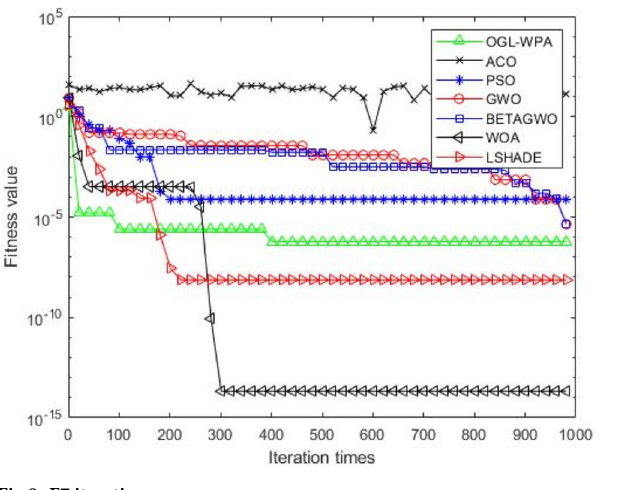
Fig 8. F7 iteration curve.